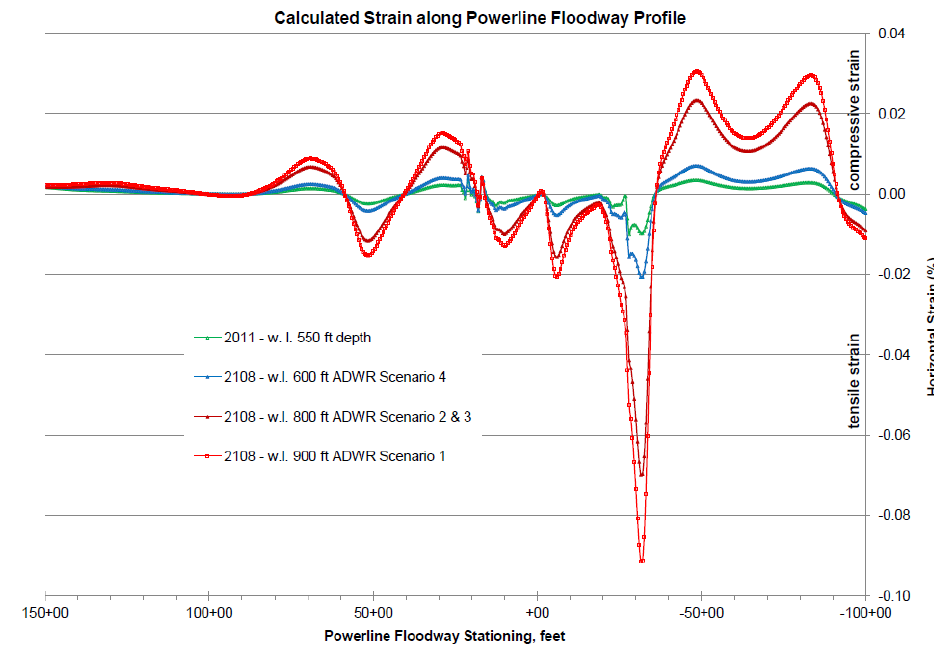
Figure 4. Prediction of horizontal strain along the Powerline floodway